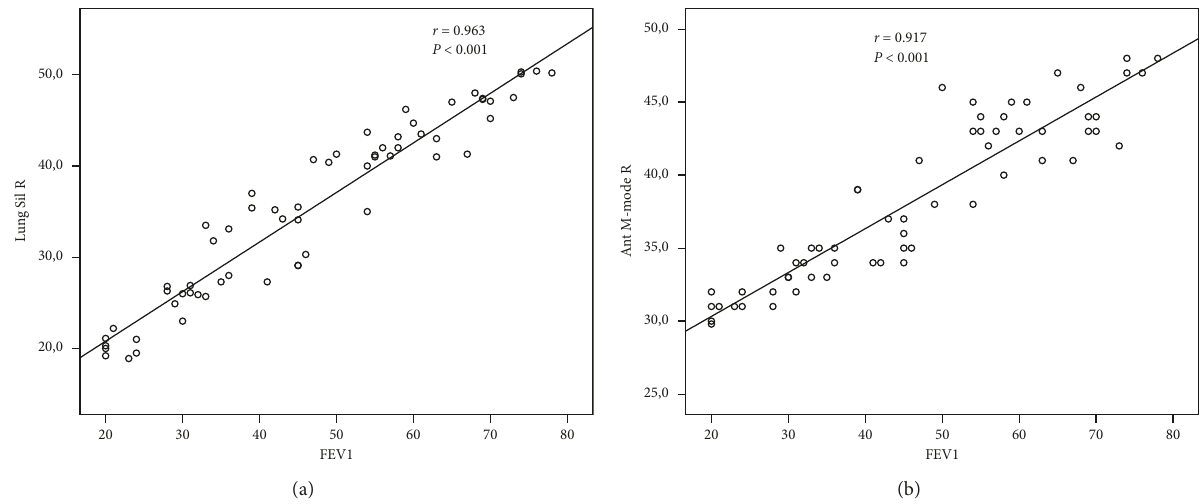
Figure 4: Correlation between (a) Lung Sil R (mm) and FEV1 (%) in COPD patients and (b) Ant M-Mode R (mm) and FEV1 (%) in COPD Patients.